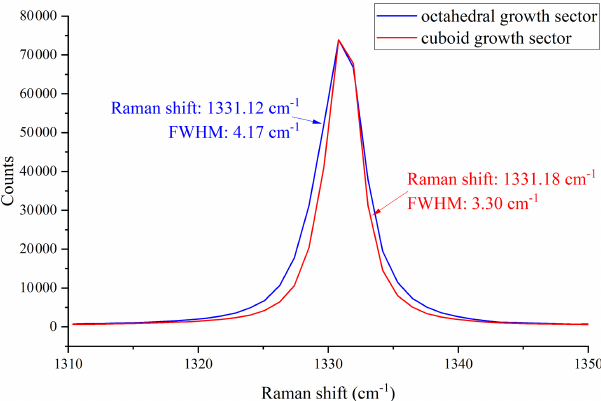
Figure 4. Two selected Raman spectra of different growth sectors in NDS-2; the blue line is the Raman band of the octahedral growth sector, and the red line is the Raman band of the cuboid growth